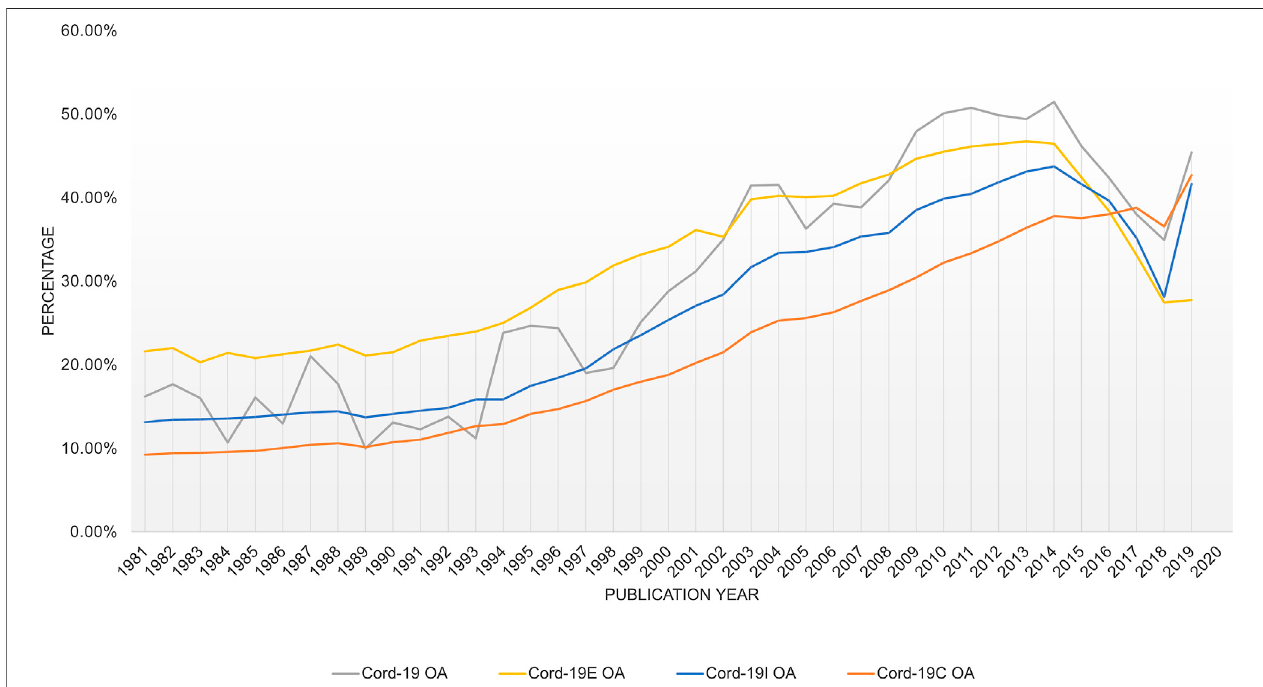
FIGURE 14 | Portion of articles with full text contents available in Microsoft Academic